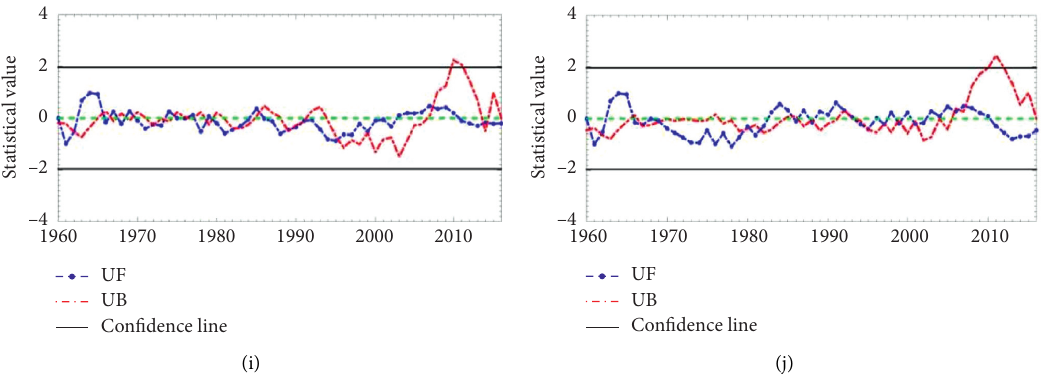
Figure 4: The trends of mean annual precipitation across stations. (a) Xiangcheng station. (b) Zhumadian station. (c) Gushi station. (d) Fuyang station. (e) Xinyang station. (f) Xichong station. (g) Shangqiu station. (h) Yingshan station. (i) Bozhou station. (j) Average